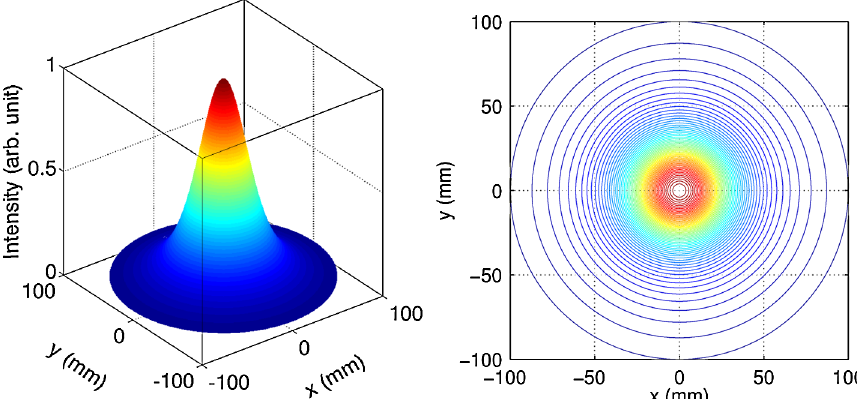
FIG. 4. The computed spatial distribution of Compton gamma-ray photons produced by a head-on collision of a circularly polarized 800 nm laser beam with an unpolarized 500 MeV electron beam. The distribution is calculated for a location 60 meters downstream from the collision point. The left plot is a three-dimensional intensity distribution, and the right plot is the contour plot of the gamma- beam intensity